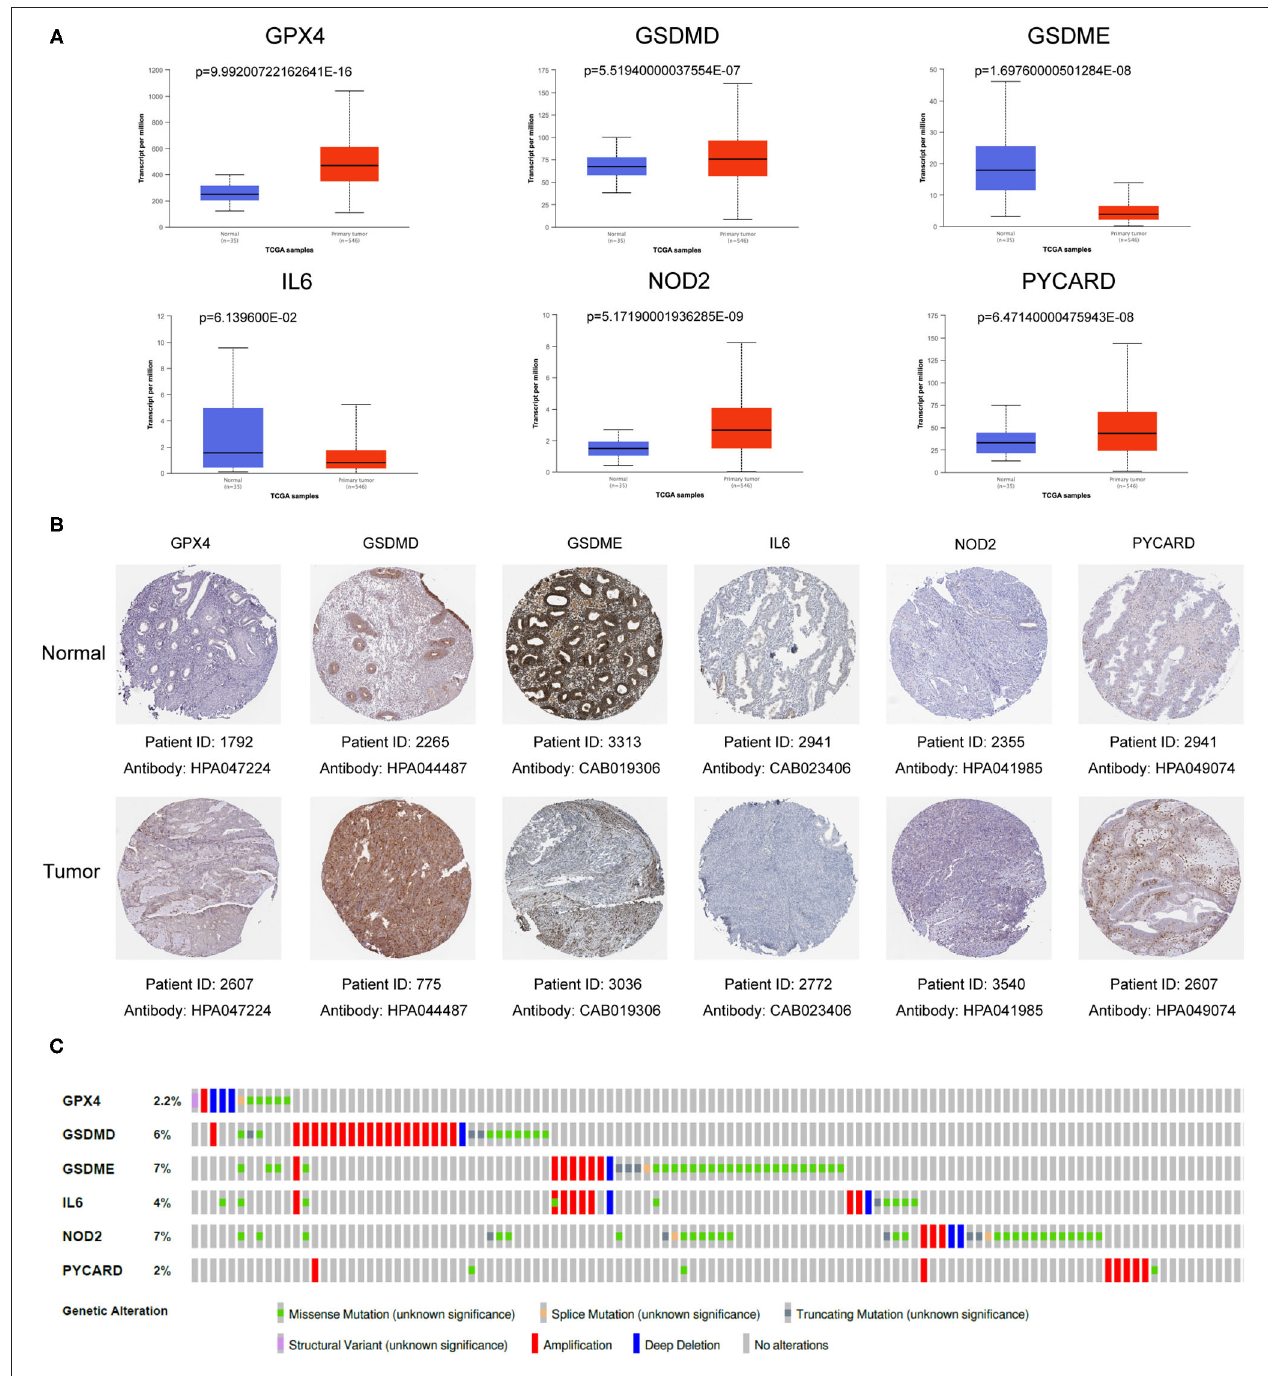
FIGURE 7 | Verification of mRNA and protein expression of six genes in the gene signature. (A) The mRNA expression levels of various genes in EC samples and normal samples. Data was acquired from the UALCAN (http://ualcan.path.uab.edu/). (B) Representative protein expression levels of each gene in tumor tissues and normal tissues. Data resourced from The Human Protein Atlas. (C) The genetic variation of six genes in the gene signature. The data was derived from the cBioPortal database (https://www.cbioportal.org/). fatty acid free radicals, which can lead to ferroptosis (35, 36). Additionally, some studies had clarified that GPX4 tumors